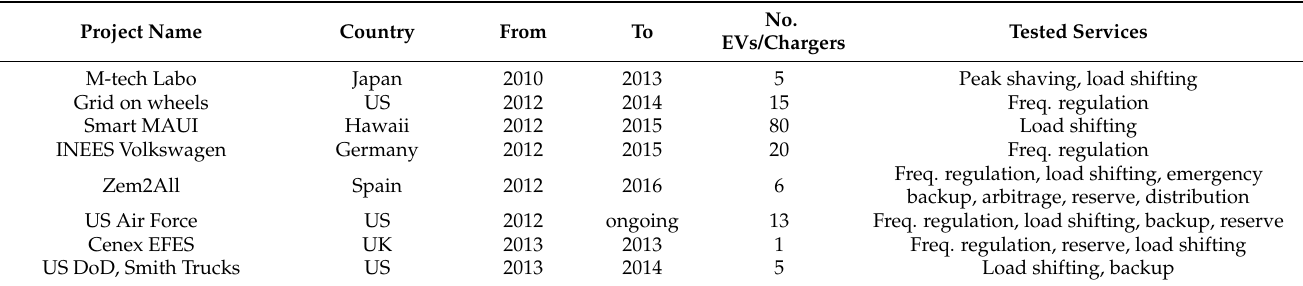
Table 1. Representative V2G projects for different services and